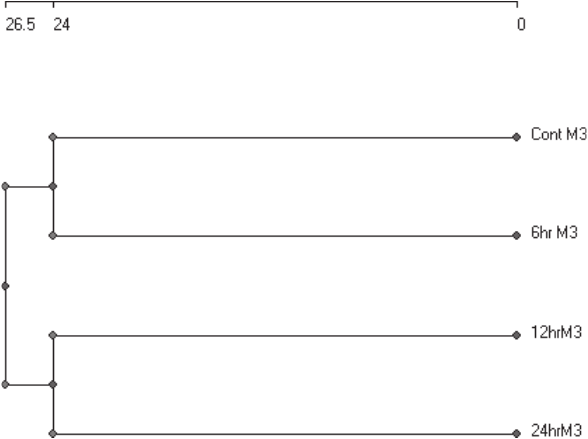
Figure 4. UPGMA based cluster tree of Vicia faba (Misr 3) cultivar exposed to 5 mM AlCl 3 for (0.0, 6, 12 and 24hr) based on (9 ISSR